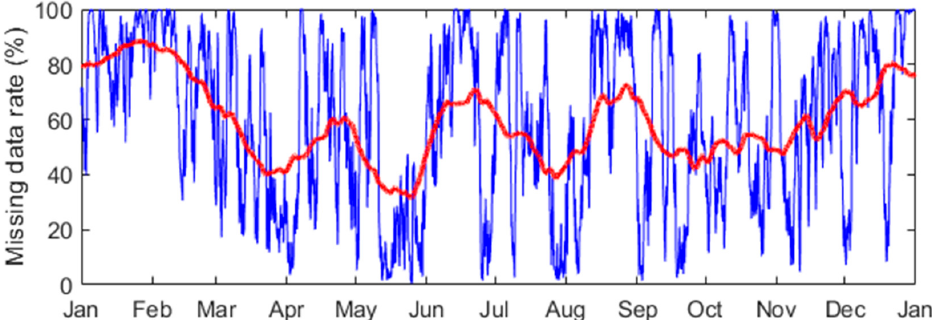
Figure 2. The daily missing data rate in 2018. The red line is the 30-day moving average.